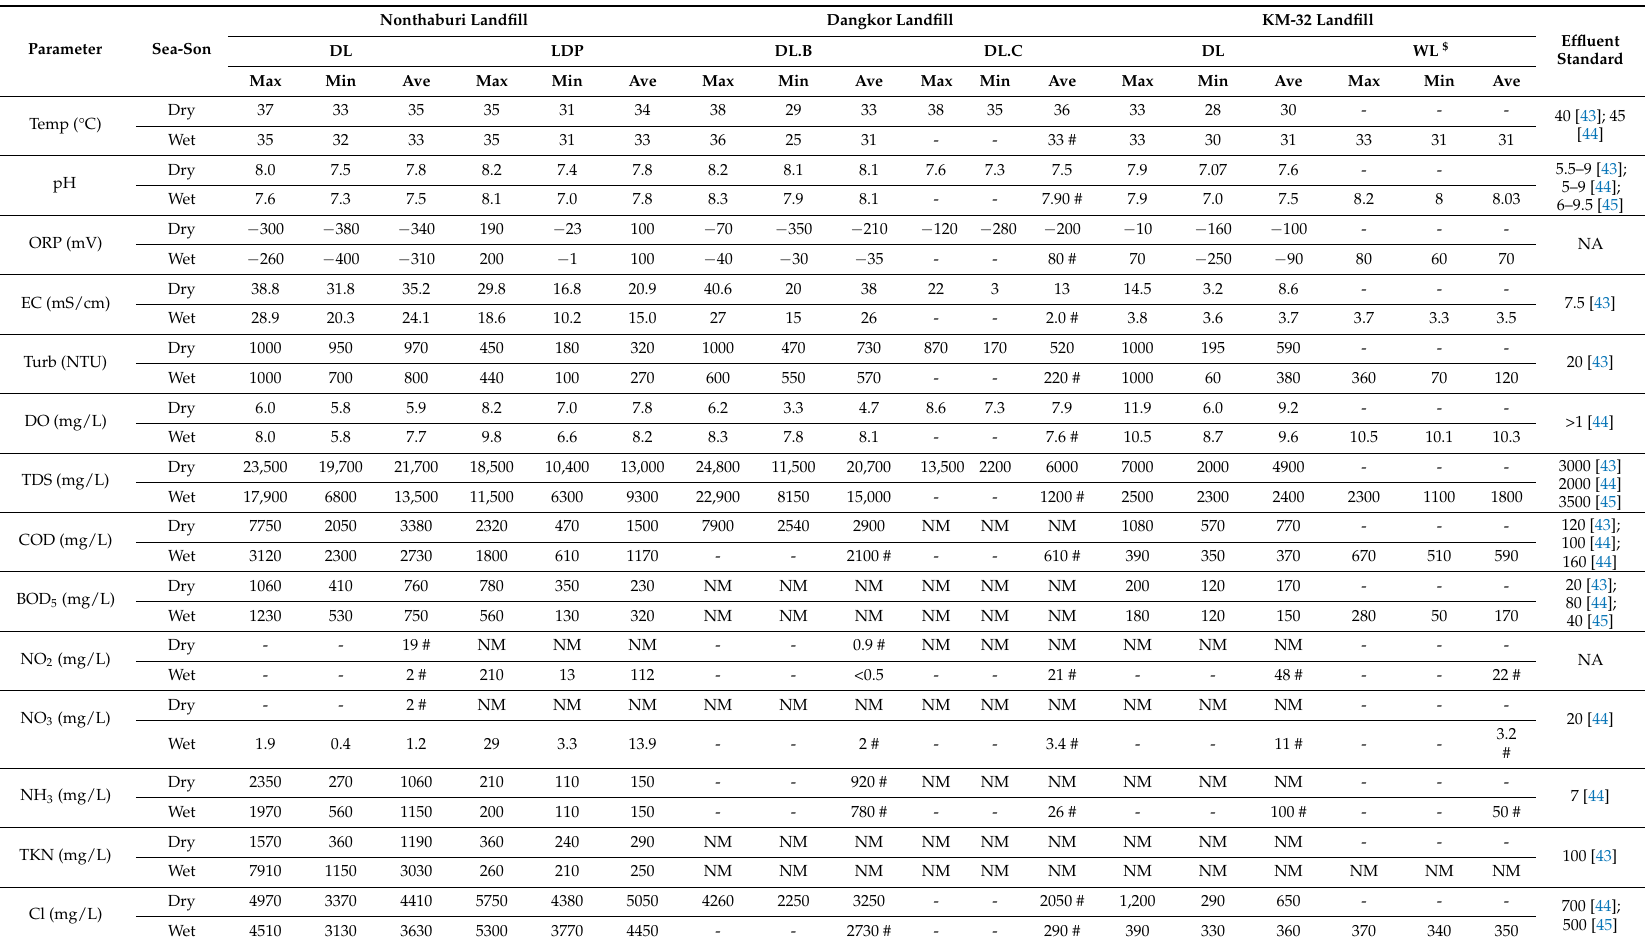
Table 2. Basic biological parameters of leachate